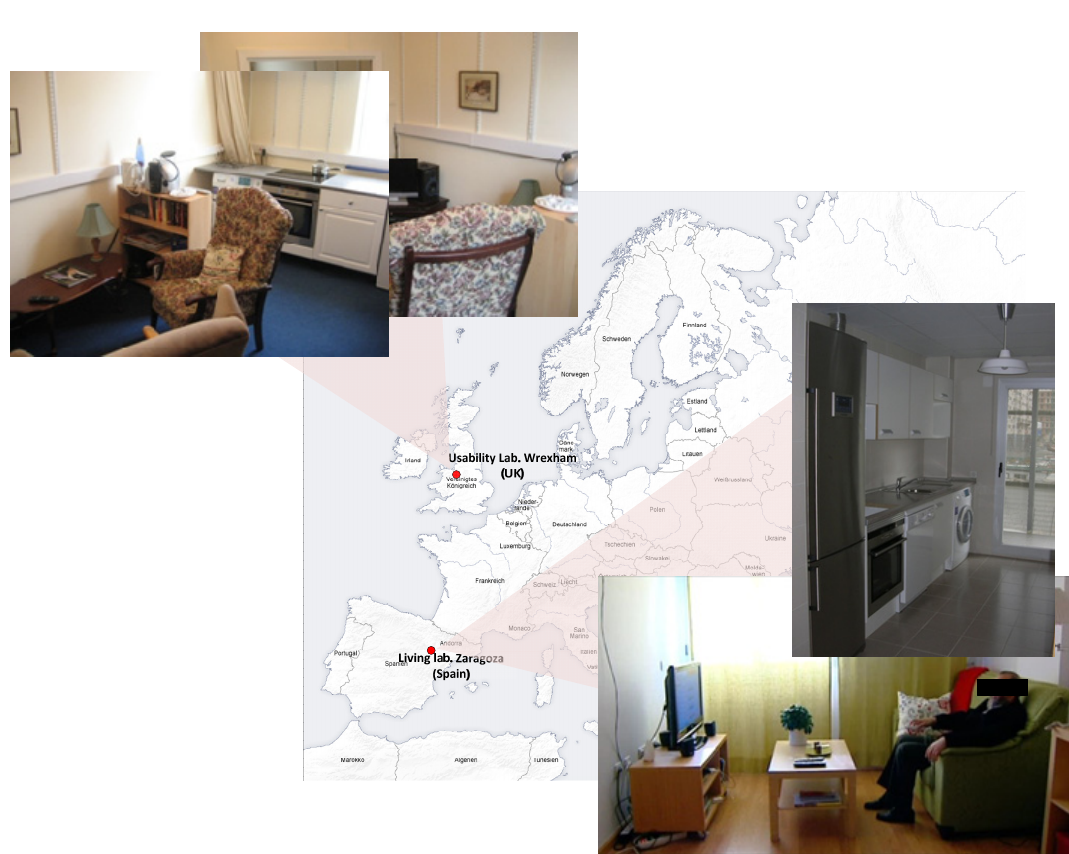
Figure 8. Evaluation places.